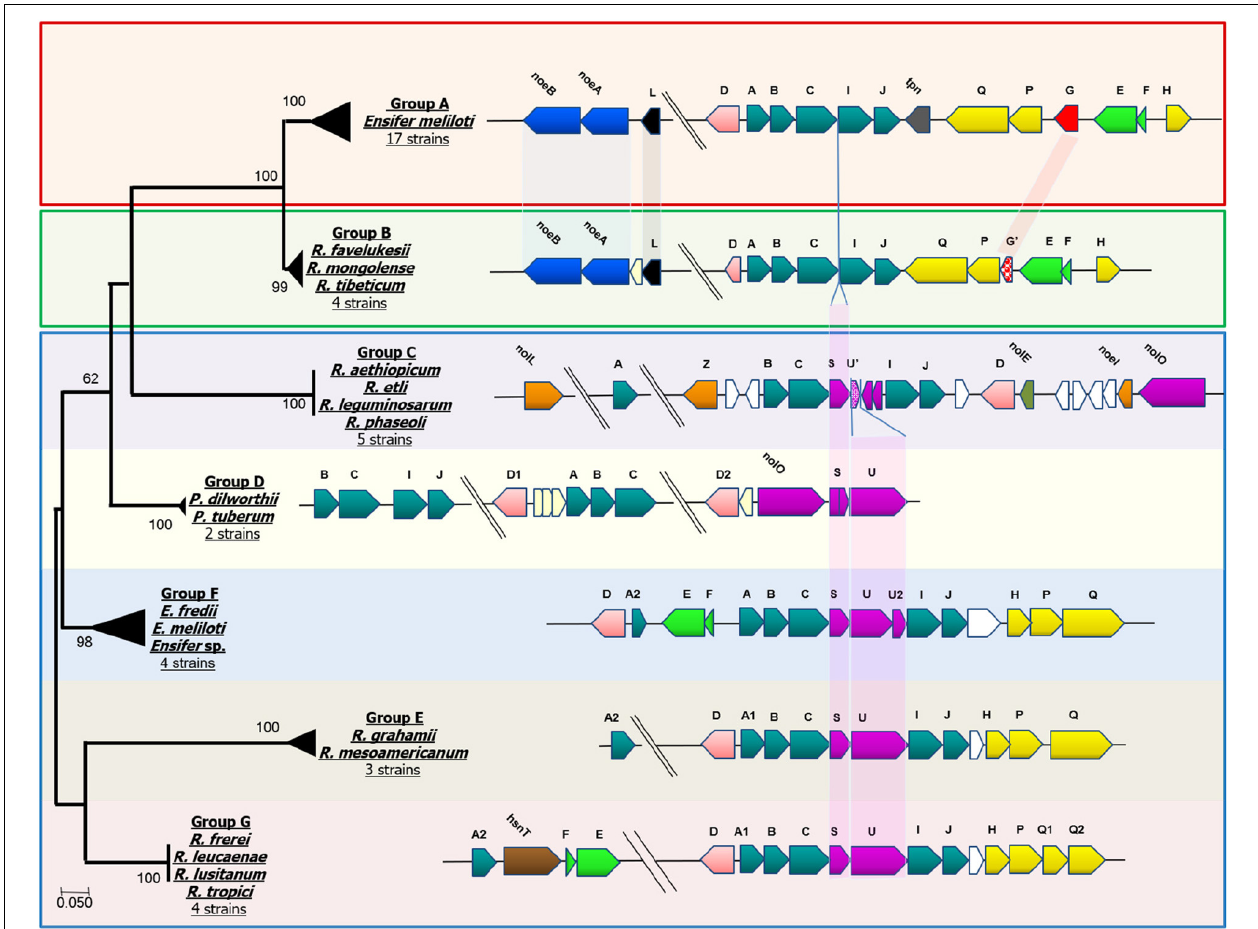
FIGURE 1 | NodA phylogenetic distribution and comparison of gene neighborhoods. Comprehensive list of strains in each group shown and not shown can be found in Supplementary Table 4 . Group A: Ensifer meliloti 1021, Ensifer meliloti 2011, Ensifer meliloti 5A14, Ensifer meliloti AE608H, Ensifer meliloti AK58, Ensifer meliloti AK83, Ensifer meliloti BL225C, Ensifer meliloti BO21CC, Ensifer meliloti CCNWSX0020, Ensifer meliloti CIAM1775, Ensifer meliloti GR4, Ensifer meliloti Mlalz-1, Ensifer meliloti MVII-I, Ensifer meliloti Rm41, Ensifer meliloti RRI128, Ensifer meliloti SM11 and Ensifer meliloti WSM1022. Group B: Rhizobium favelukesii OR191, Rhizobium favelukesii LPU83, Rhizobium mongolense USDA 1844, Rhizobium tibeticum CGMCC 1.7071. Group C: Rhizobium aethiopicum HBR26, Rhizobium etli CFN 42, Rhizobium leguminosarum s.s. 4292, Rhizobium leguminosarum genospecies K FA23, Rhizobium phaseoli CIAT 652. Group D: Paraburkholderia dilworthii WSM3556 and Paraburkholderia tuberum WSM4176. Group E: Rhizobium mesoamericanum STM 3625 and Rhizobium mesoamericanum STM6155. Group F: Ensifer fredii GR64, Ensifer sp. 4H41 and Ensifer meliloti GVPV12. Group G: Rhizobium leucaenae USDA 9039, Rhizobium lusitanum P1-7 and Rhizobium tropici